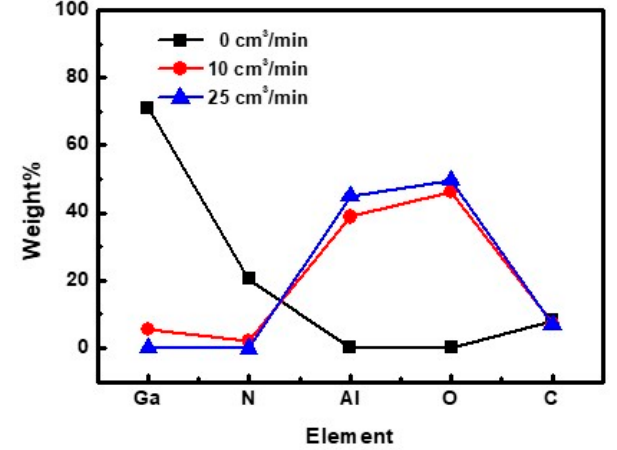
Figure 3. Quantitative SEM–EDS results of the GaN-epi/PSSs decomposed at 1200 °C for 3 h under hydrogen flow rates of 0, 10, and 25 cm 3 /min.